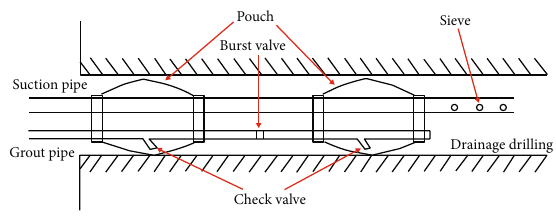
Figure 5: Schematic diagram of the structure of the bag-type grouting